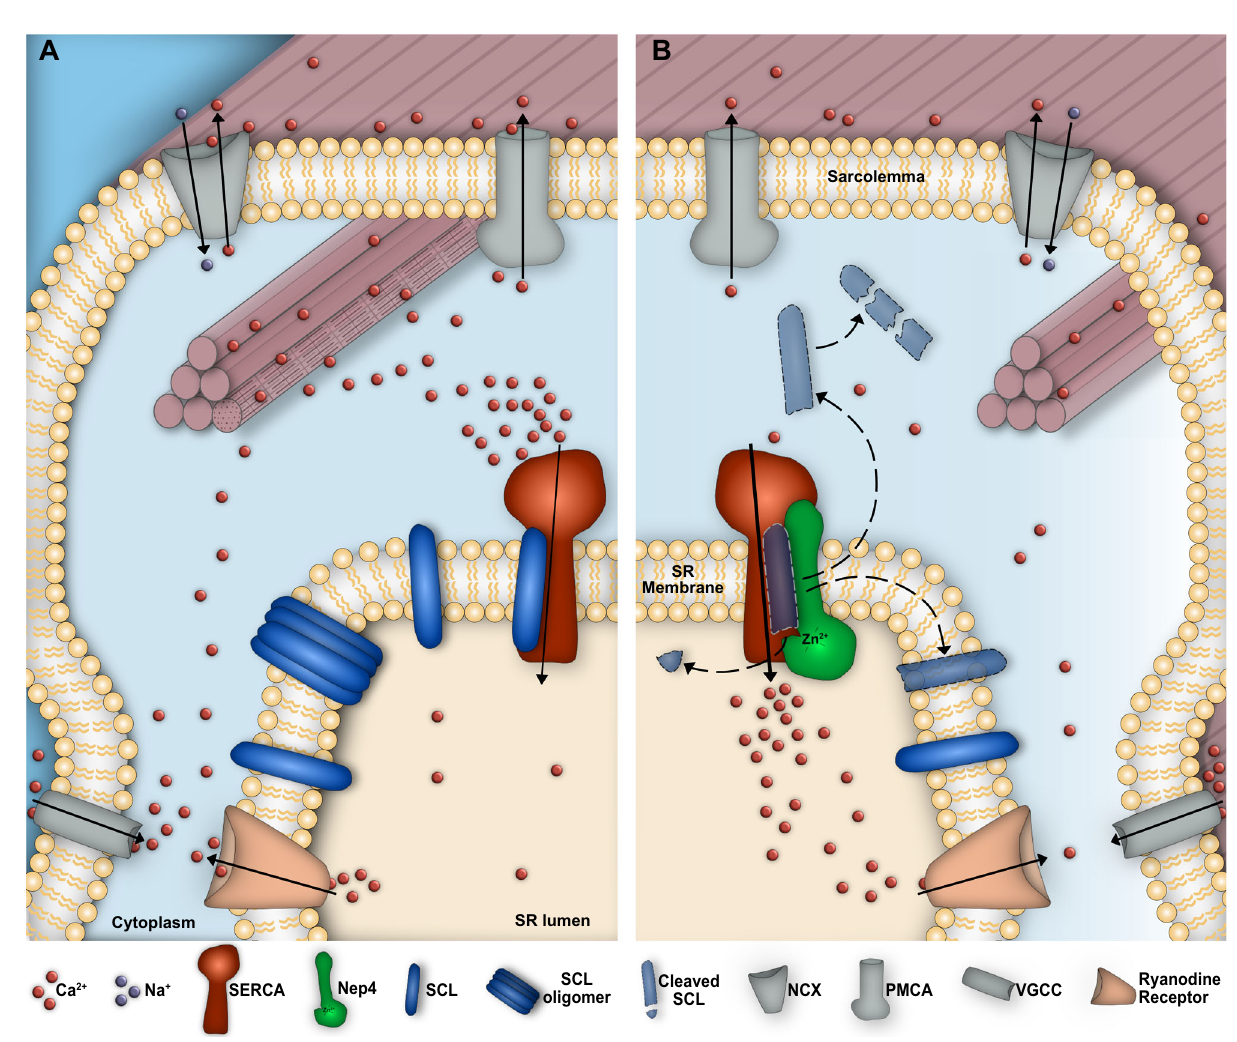
B Nep4-mediatedSCLhydrolysisreducestheabilityofthe peptidesto oligomerize and releases them from the SR membrane, thus preventing SCL accumulation and exchanger, PMCA plasma membrane Ca 2+